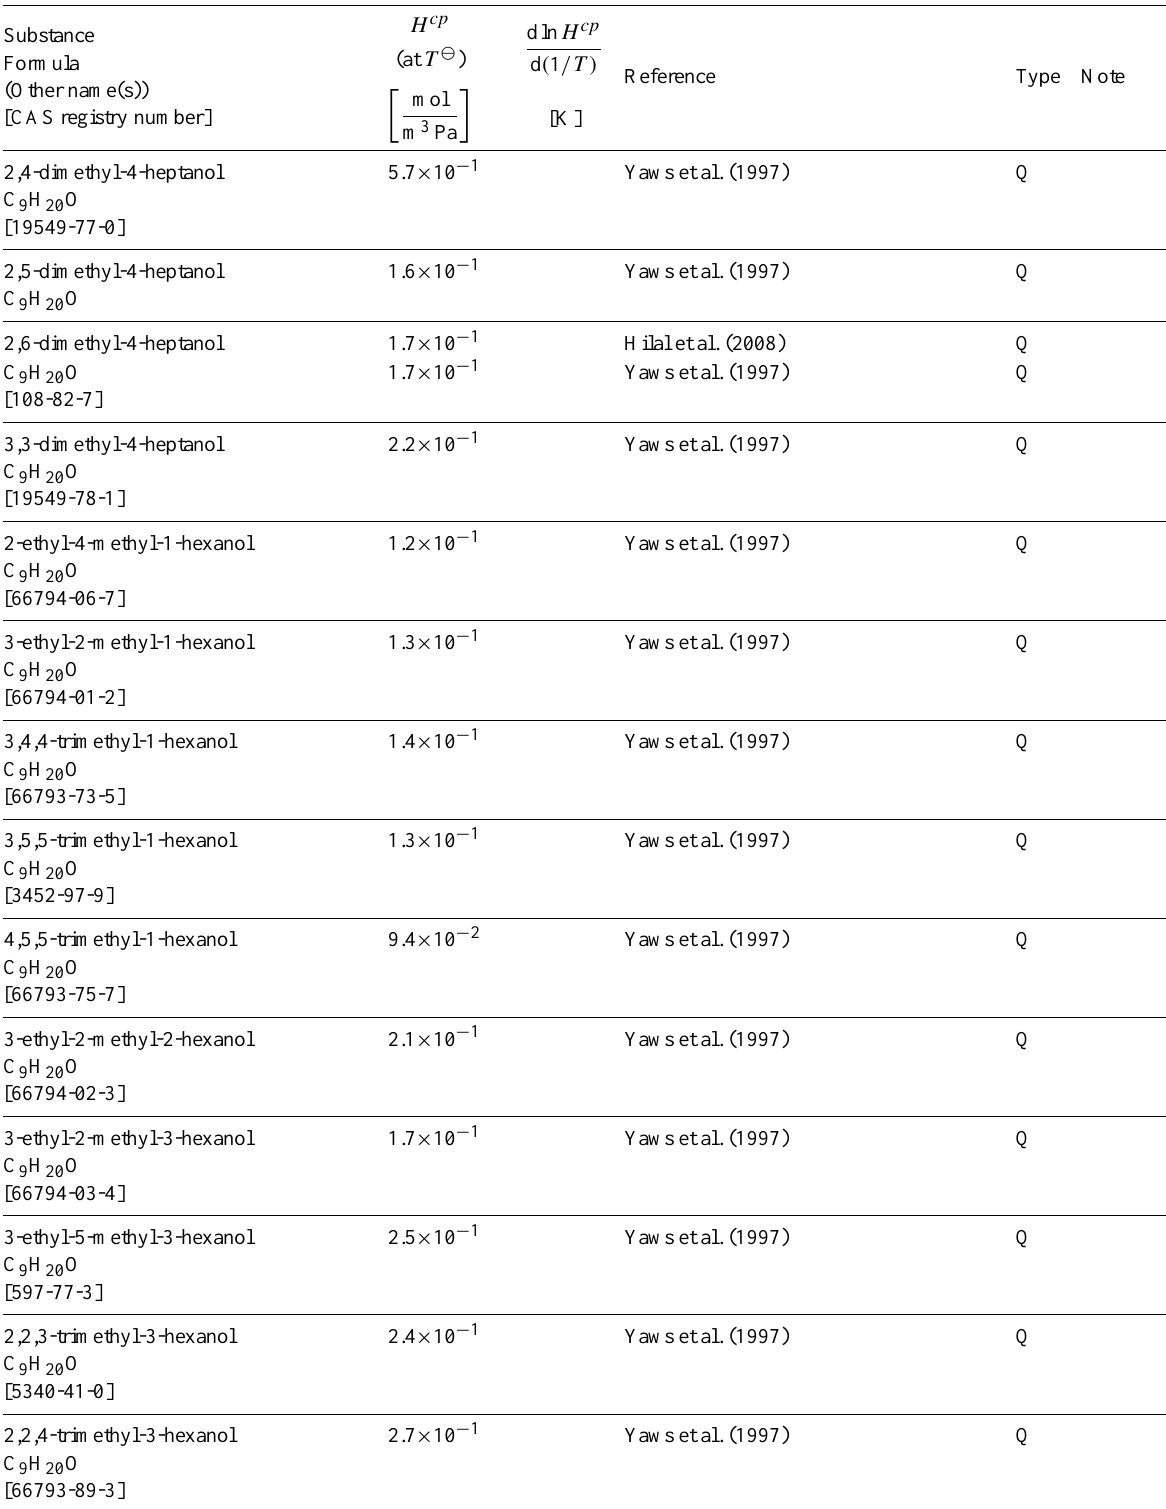
Table 6: Henry’s law constants for water as solvent